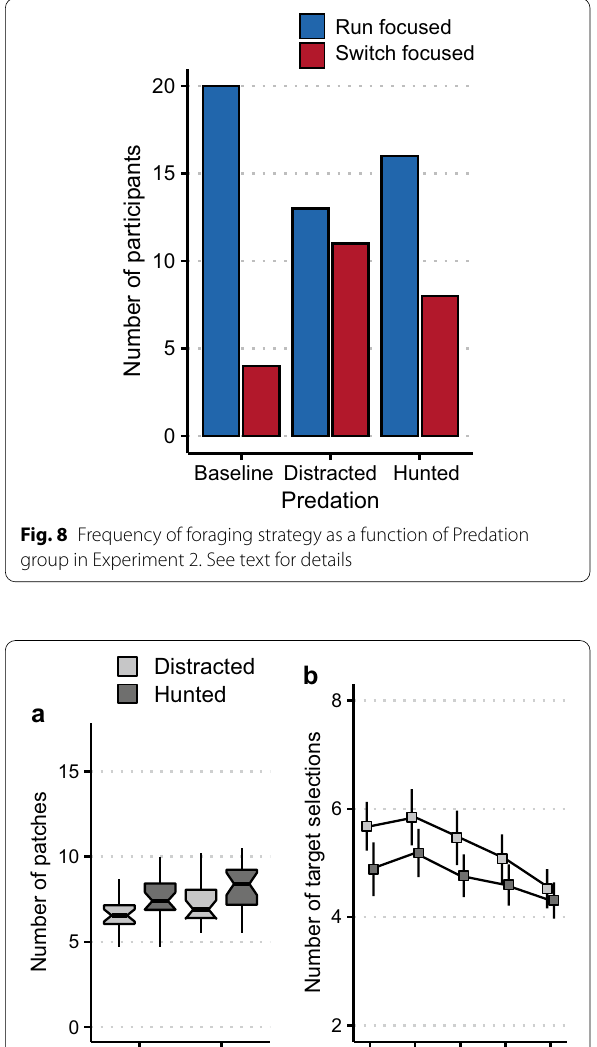
Fig. 9 a Number of patches as a function of Predation (Distracted/ Hunted) and Target (Feature/Conjunction). Horizontal lines show the central tendency (median) of each distribution, with notches indicating 95% confindence intervals. Boxes identify the upper (75%) and lower (25%) quartiles, with the whiskers indicating maximum and minimum values. b Average number of targets per patch as a function of Predation. Error bars indicate 95% confidence